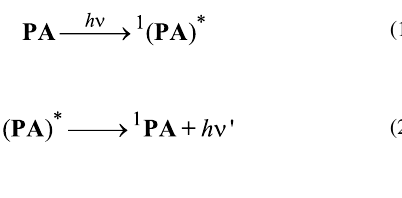
modes of the S 1 (v’ = 2, v’ = 1) into its lowest vibrational mode (v’ = 0), vibrational relaxation from lowest vibrational mode of the S 1 into higher vibrational modes (for example v = 2) of the ground state (S 0 ), intermolecular energy transfer from vibra- tionally hot molecules to their cold surrounding (vibrational cooling = VC) [73,74], and fluorescence (F) [75,76].